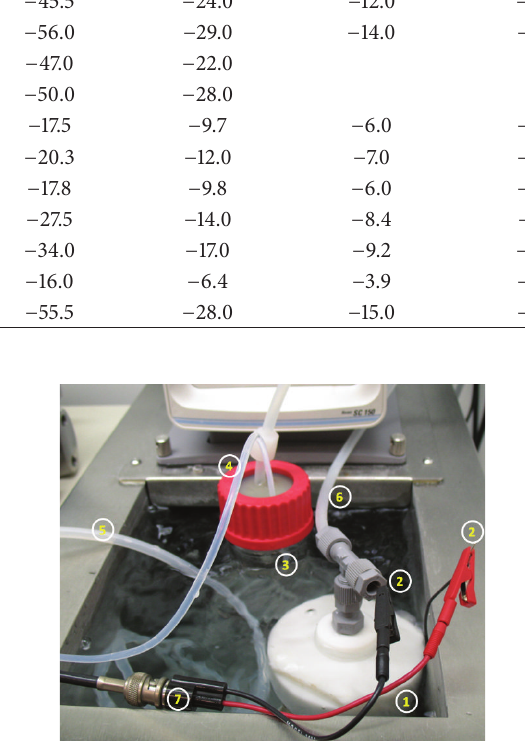
Figure 1: The main part of the setup for Streaming Potential measurements as a function of temperature. 1: core holder; 2: Ag/AgCl electrodes; 3: solution container; 4: tubing used to pump the solution from the container; 5: tubing connecting the pump outlet and the core holder inlet; 6: tubing for recirculation; 7: shield cable for electrical potential